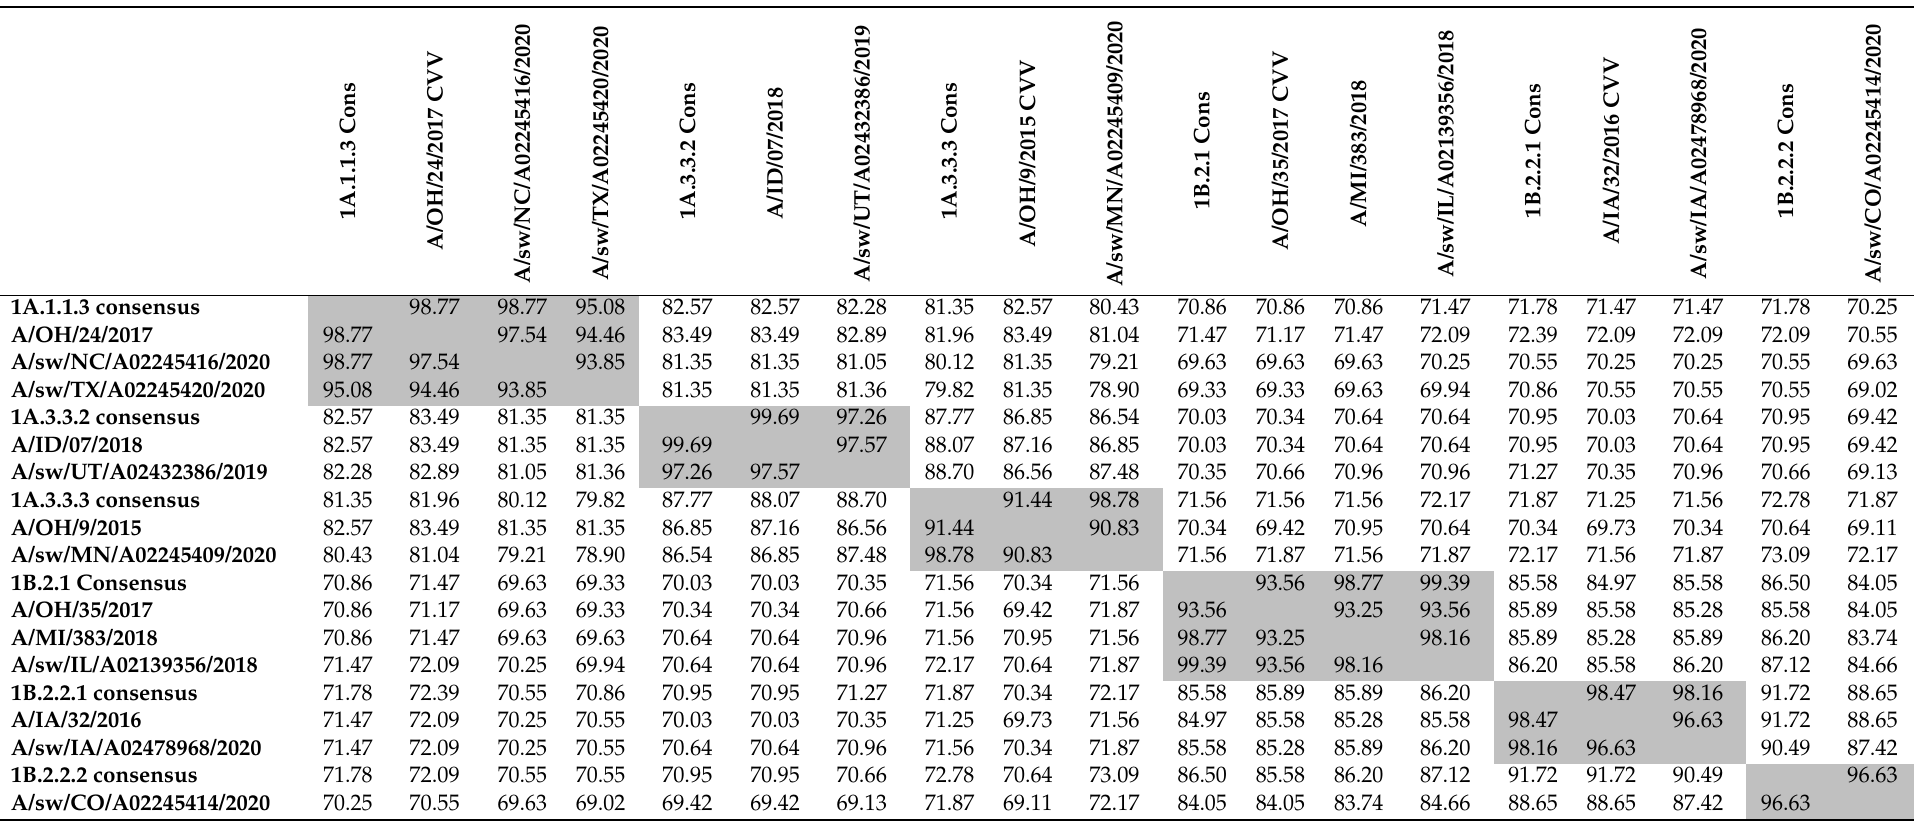
Table 1. Pairwise amino acid sequence similarity of the HA1 domain from swine H1 clade consensus sequences to CVV or seasonal vaccine virus and the swine hemagglutinin clade representative viruses used in this study. Within-clade comparisons are highlighted in